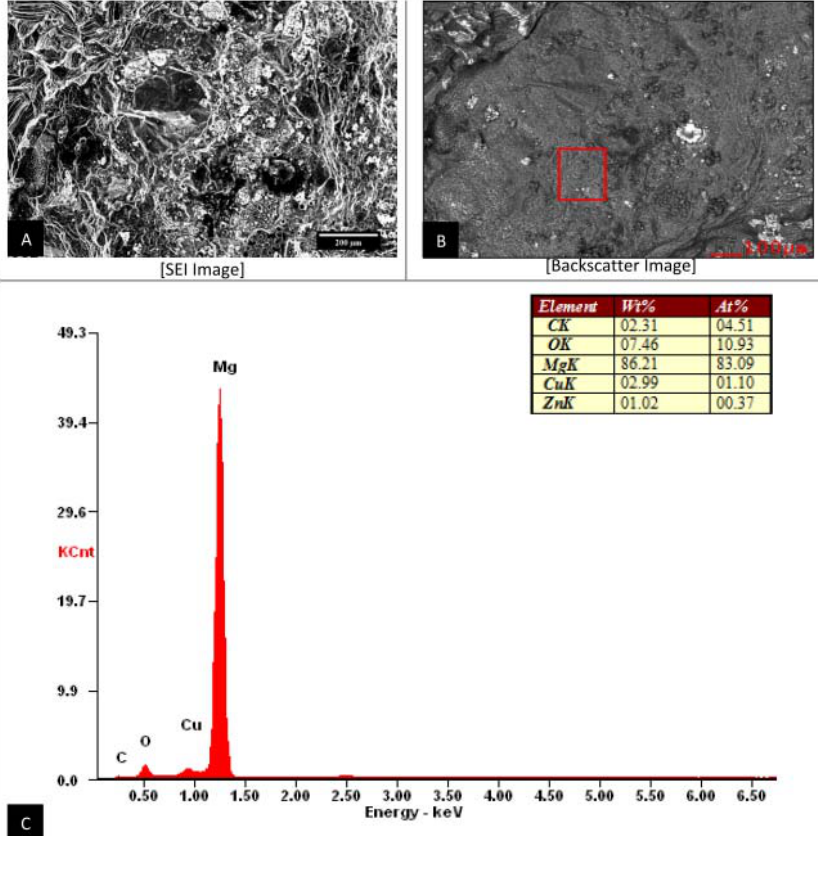
Figure 7. Mg-Zn-Cu alloy casting defect in tensile specimen leading to premature